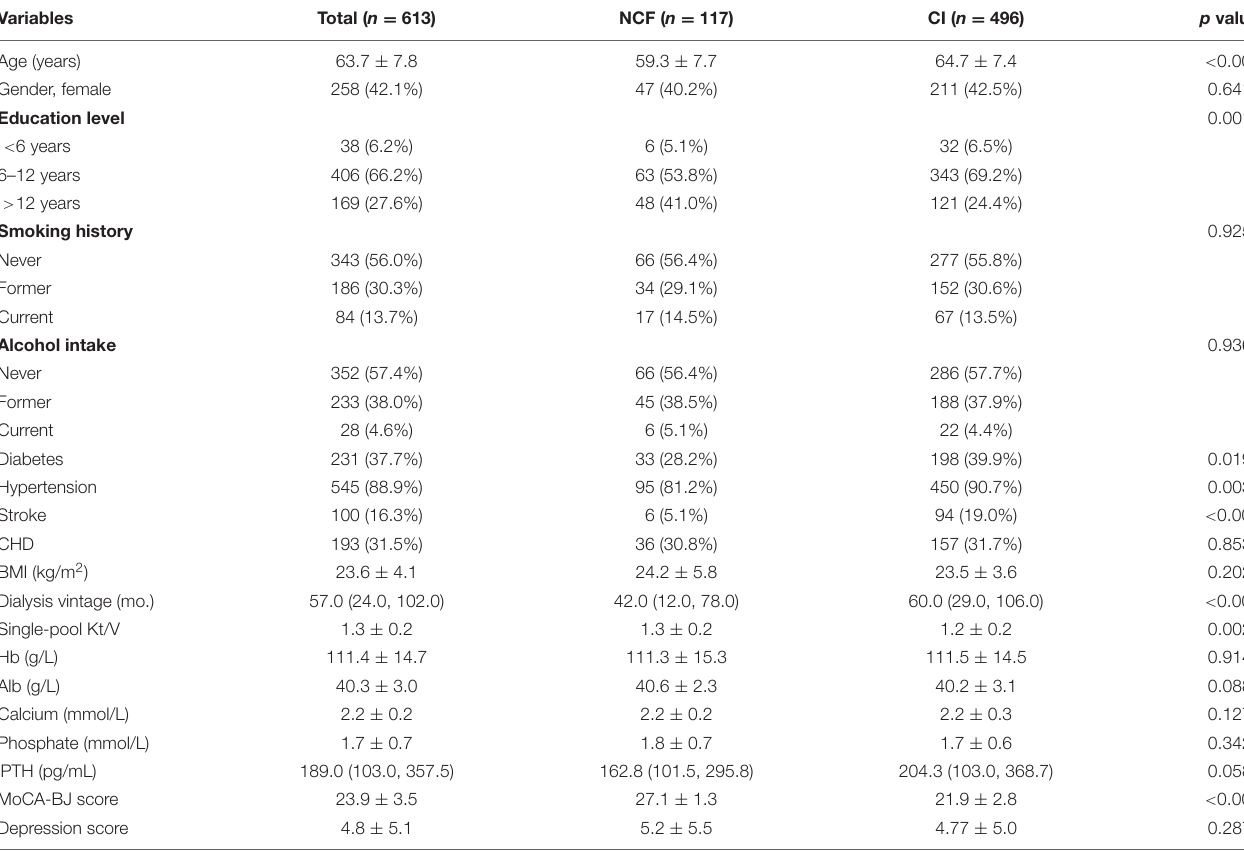
TABLE 1 | Demographics and clinical characteristics of the study